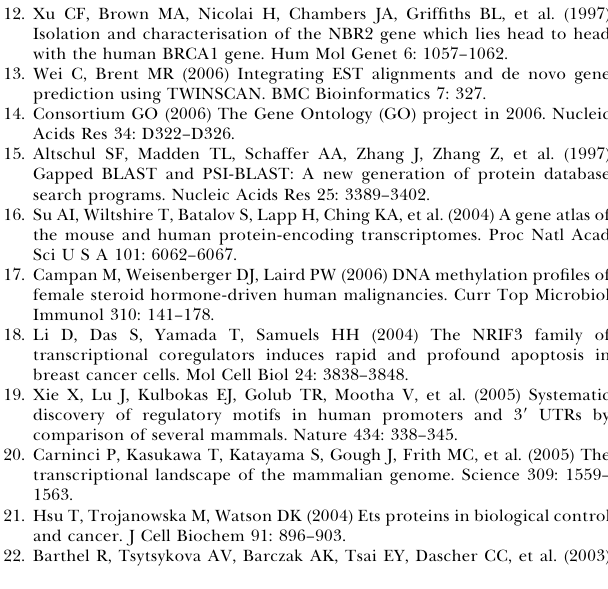
Table S1. Endometrial Cancer Genes with Bidirectional Promoters Found at doi:10.1371/journal.pcbi.0030072.st001 (28 KB DOC). Table S2. Expression Clusters Over- and Under-Represented in Bidirectional Promoters Found at doi:10.1371/journal.pcbi.0030072.st002 (69 KB DOC). Table S3. Bidirectional Promoters in Breast and Ovarian Cancer Gene Co-Expression Clusters Found at doi:10.1371/journal.pcbi.0030072.st003 (30 KB